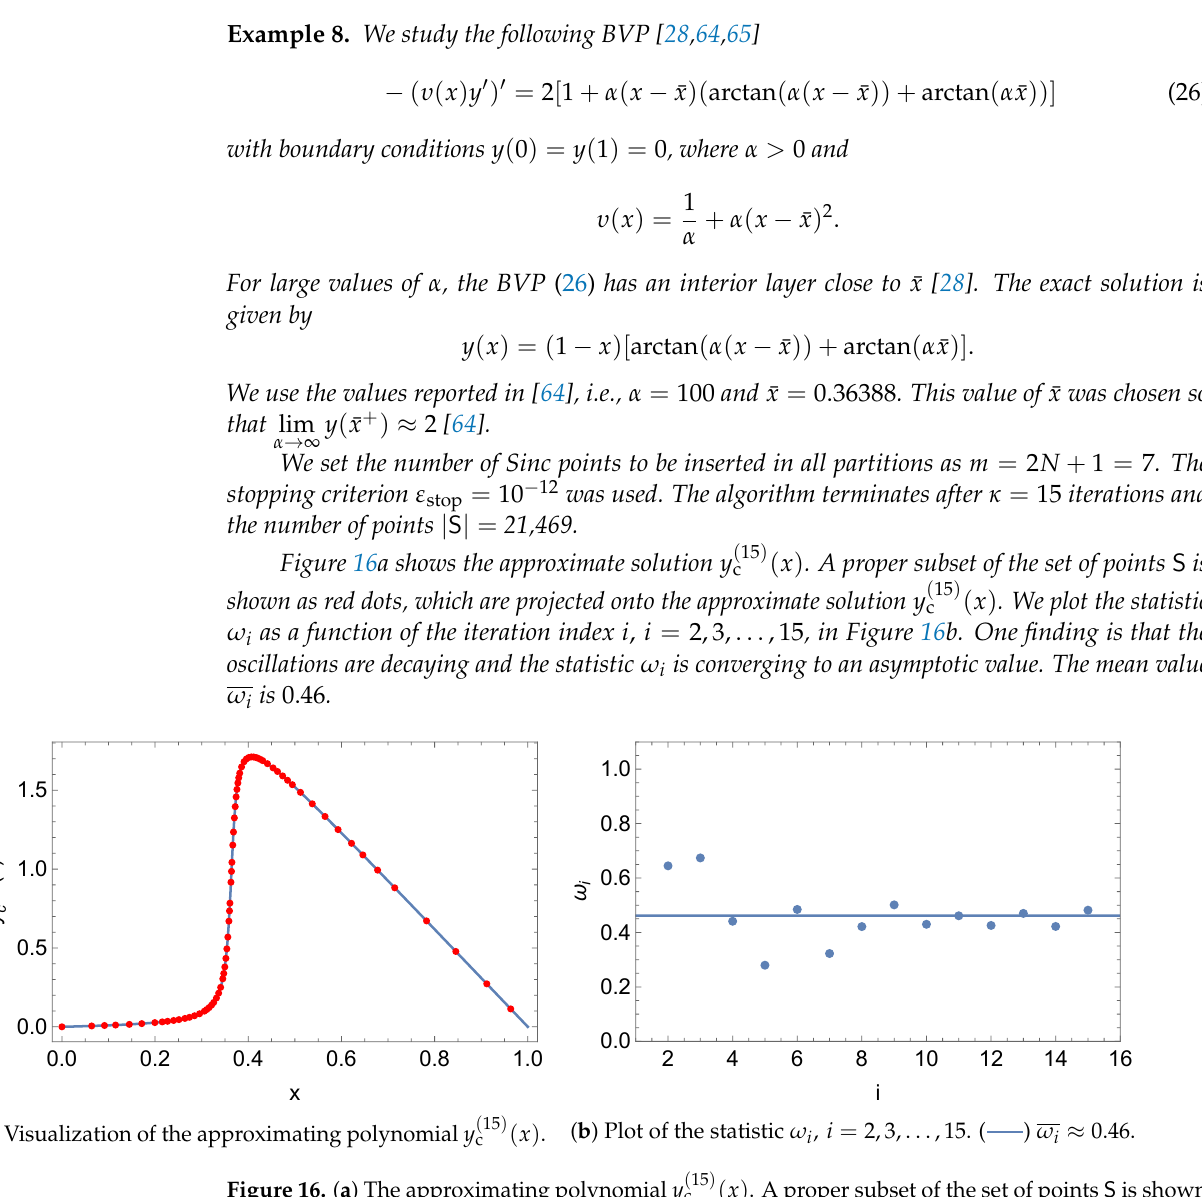
Figure 16. ( a ) The approximating polynomial y ( b ) Plot of the statistic ω i . ( ) ω i ≈